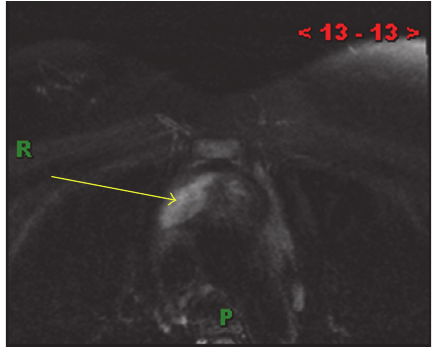
Figure 3: (MR T2) axial T2 fat saturated image showing a hyper- intense heterogenous mass suggestive of cystic components (yellow arrow).